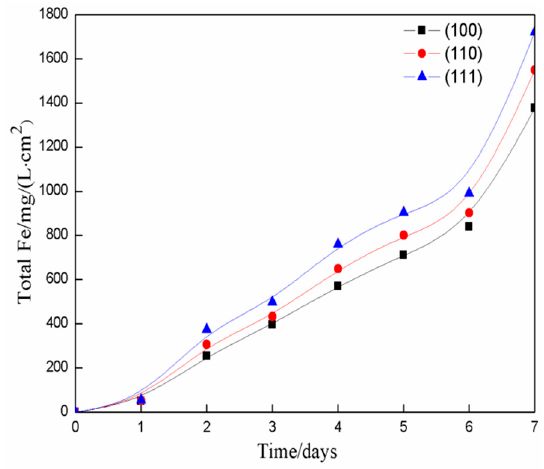
Figure 5. “Total iron” concentration in acid solution with time.